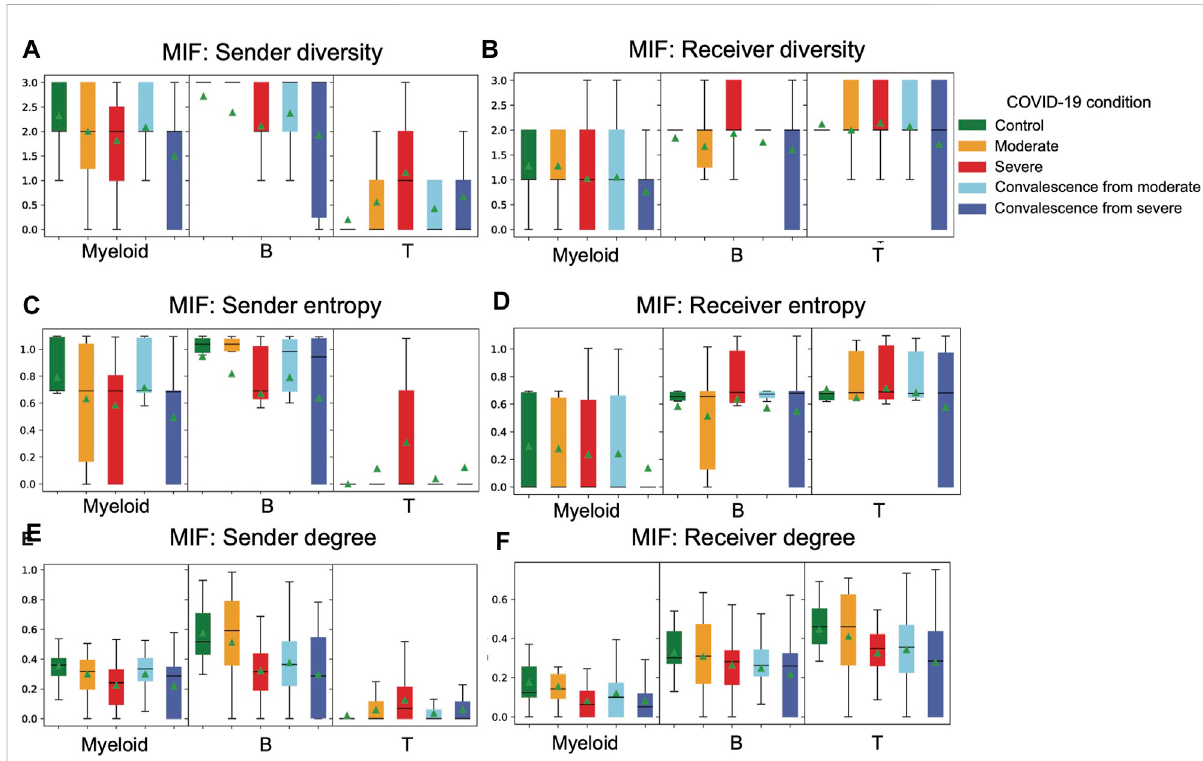
FIGURE 3 DistributionofcelltypediversitystatisticsindifferentCOVID-19conditionsarevisualized. (A) DistributionofsenderdiversityinMIFpathway.Thereis aconsistentpatternofdecreasingdiversityfromcontroltomoderatetoseveregroupsandfrommoderateconvalescenttosevereconvalescentgroups in myeloid and B cell types as senders. The pattern in T cell type is different from the patterns in myeloid and B cell types. (B) Distribution of receiver diversityintheMIFpathway.Thereisadecreasingpatternofdiversityfromcontroltomoderatetoseveretomoderateconvalescenceandtosevere convalescence groups in myeloid as a receiver. (C) Distribution of sender entropy in the MIF pathway. The patterns are similar to sender diversity. (D) DistributionofreceiverentropyintheMIFpathway.Thepatternsaresimilartoreceiverdiversity. (E) DistributionofsenderdegreeintheMIFpathway.The patternsaresimilartosenderdiversityandsenderentropy. (F) DistributionofreceiverdegreeintheMIFpathway.WhenBcellsarereceivercells,thereisa consistent decreasing trend of receiver degree from control all the way to severe convalescence